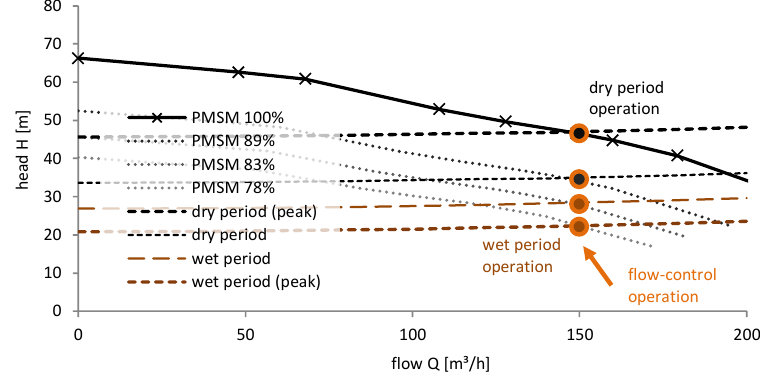
Figure 7. System curves for dry period and wet period operations, and PMSM pump curves vs flow (at 100%, 89%, 83%, and 78% speed levels), and the associated working points.